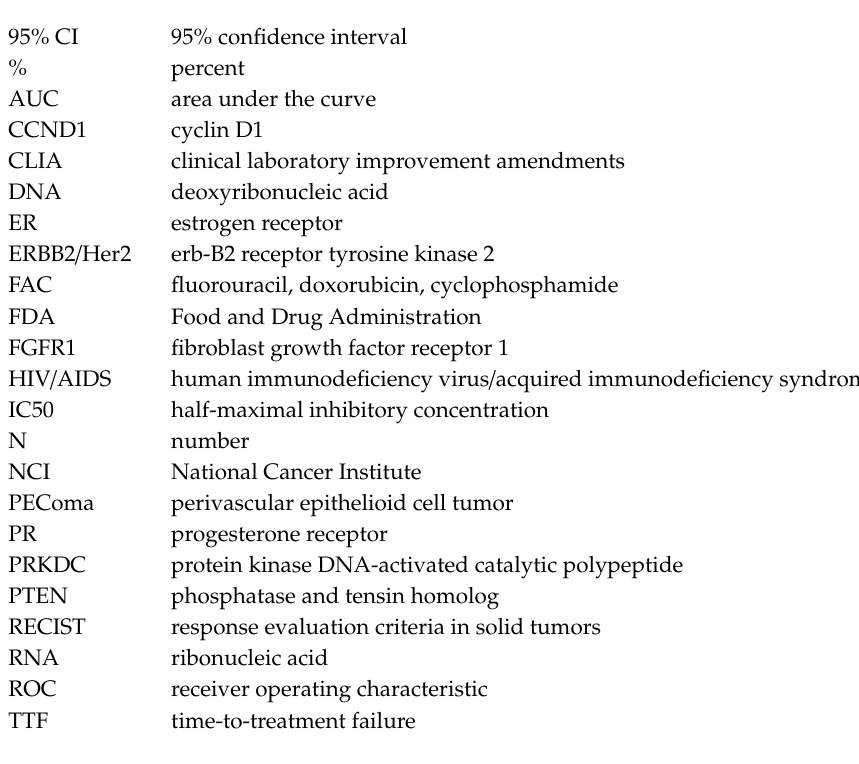
Table S1: List of publications included in the analysis; Table S2: Description of the 70 exceptional responders